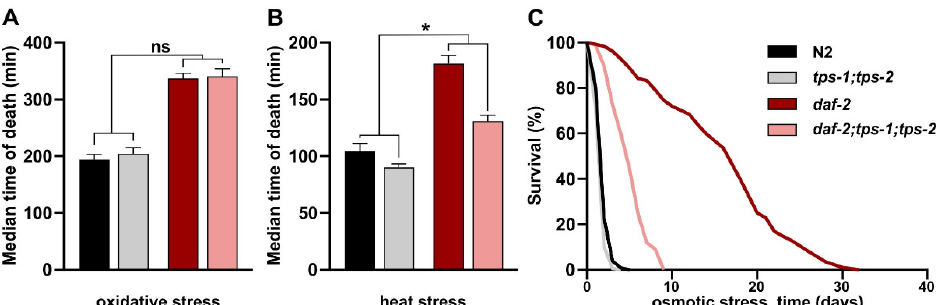
Figure 4. The role of double tps deletion tps-1(ok373);tps-2(ok526) in stress resistance of wild-type N2 and daf-2(e1370) : Stress survival measured with the LFASS method [44] ( A ) oxidative stress, 0.28% tert -butyl hydroperoxide (TBHP); ( B ) heat stress, 40 °C; ( C ) osmotic stress survival 500 mM NaCl. Error bars in ( A , B ) indicate SEM of three independent replicates. ns: p > 0.05, * p ≤ 0.05. Survival data of all replicates are summarized in Table S4.